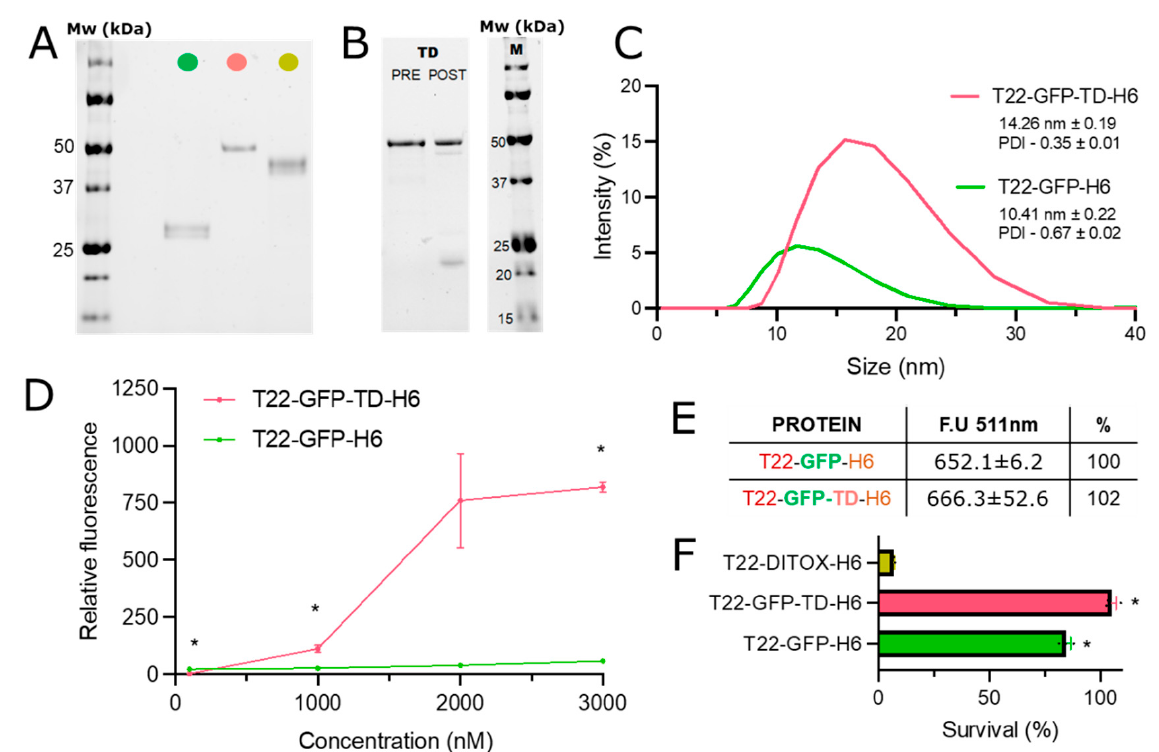
Figure 2. Characterization of T22 ‐ GFP ‐ TD ‐ H6 nanoparticles and their cellular accumulation. ( A ) Protein gel electrophoresis of the three proteins used in the study (T22 ‐ GFP ‐ H6, in green; T22 ‐ GFP ‐ TD ‐ H6, in dark pink; T22 ‐ DITOX ‐ H6, in dark yellow). ( B ) Protein gel electrophoresis of T22 ‐ GFP ‐ TD ‐ H6, before (pre) and after (post) exposure to recombinant furin. ( C ) Intensity size distribution of T22 ‐ GFP ‐ H6 and T22 ‐ GFP ‐ TD ‐ H6, measured by Dynamic Light Scattering (DLS). Inset values indicate mean size measured by intensity (nm) and polydispersity index (PDI) ± standard error. ( D ) Relative intracellular accumulation of T22 ‐ GFP ‐ H6 and T22 ‐ GFP ‐ TD ‐ H6 in HeLa cells after 24 h of exposure, at four different concentrations (100 nM, 1000 nM, 2000 nM, 3000 nM). Data are shown as mean ± standard error. Fluorescence values are referred to those of background cells. Significant statistical differences between data pairs (T22 ‐ GFP ‐ H6 vs. T22 ‐ GFP ‐ TD ‐ H6 at a respective concentration) are represented by * at p < 0.05. ( E ) Intrinsic fluorescent emission of T22 ‐ GFP ‐ H6 and T22 ‐ GFP ‐ TD ‐ H6, exciting at 488 nm and detecting at 511 nm. Fluorescence of T22 ‐ GFP ‐ H6 is stated as 100%. ( F ) HeLa cell viability upon exposure to 1000 nM of T22 ‐ GFP ‐ H6, T22 ‐ GFP ‐ TD ‐ H6 and T22 ‐ DITOX ‐ H6 for 48 h. Data are shown as mean ± standard error. Statistical significance with respect to the toxin group (T22 ‐ DITOX ‐ H6) is represented by * p < 0.05.